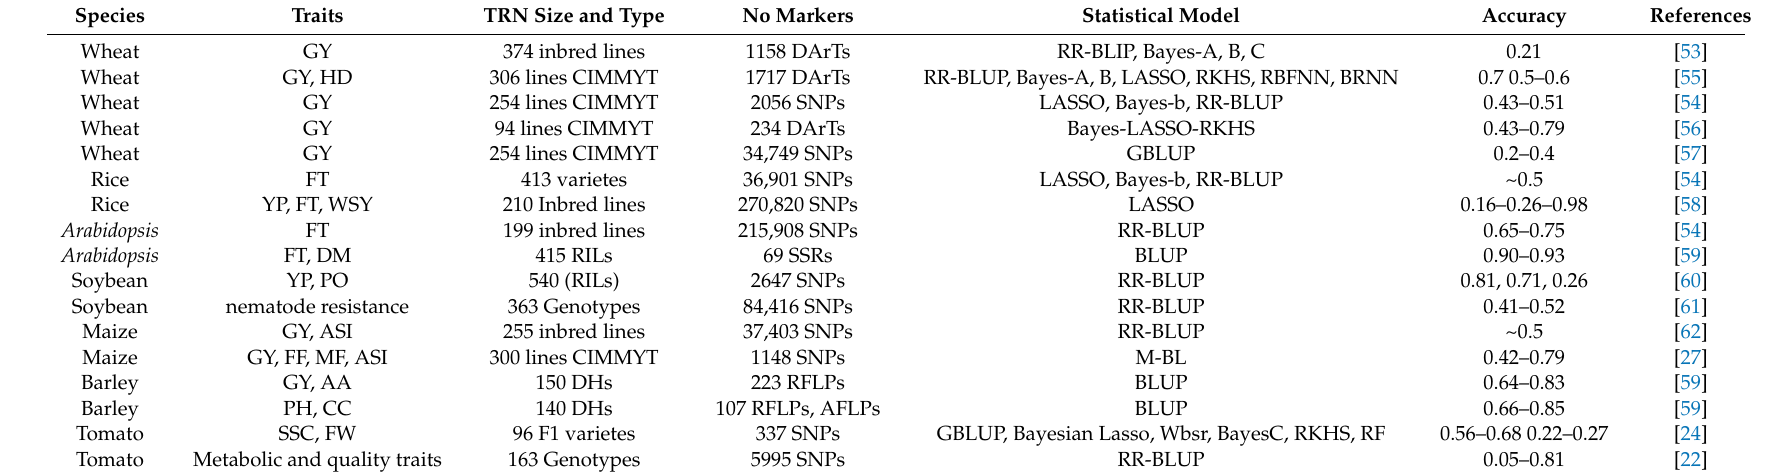
Table 1. Genomic selection studies in plant